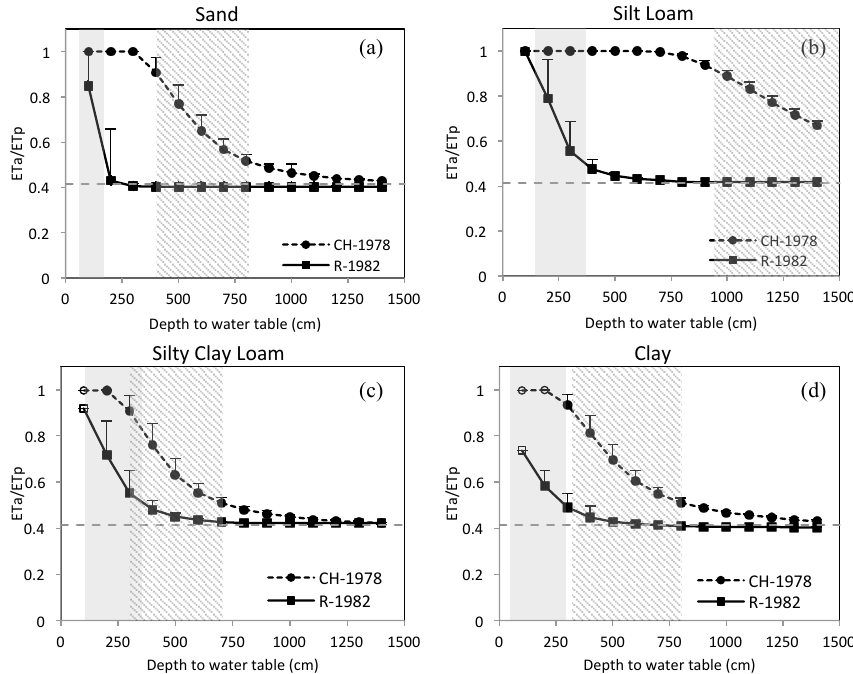
Fig. 4. Long-term mean annual ET a /ET p versus water table depth, based on the daily Hydrus-1D 10-year simulations (see Table 3). Shown are model results for (a) sand, (b) silt loam, (c) silty clay loam, and (d) clay. Dashed and solid lines indicate model solutions using Clapp and Hornberger (1978) and Rawls et al. (1982) soil parameters, respectively (both with 1.5-cm node spacing). Vertical “error bars” represent solutions using 30-cm node spacing, while empty squares or circles indicate solutions that did not converge using a 30-cm nodal distance. The horizontal, dashed line (in grey) indicates the 10-year mean annual P /ET p ratio, where ET p is calculated from the Priestley-Taylor relationship. Gray shaded and hatched areas represent approximate critical zones for R-1982 and CH-1978 soil parameters, respectively.